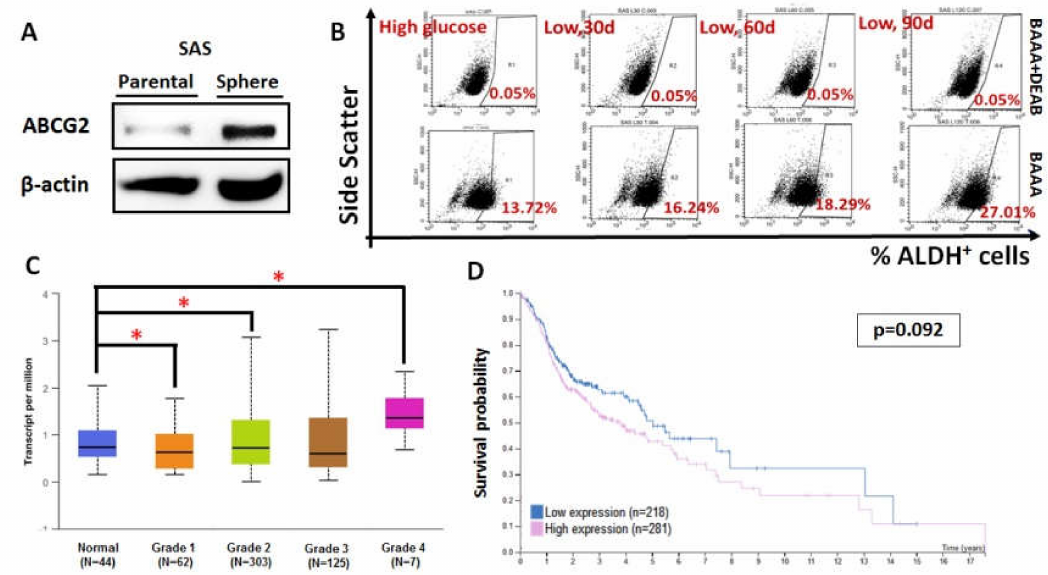
Figure 5. ABCG2 expression is associated with increased stemness, tumor grade, and HNC prognosis. ( A ) ABCG2 was enriched in SAS sphere culture compared with SAS parental cells. ( B ) Aldehyde dehydrogenase (ALDH) + cell population gradually increased once SAS cells were cultured in a medium containing lower glucose. ABCG2 expression increased with increasing low-glucose culture time. ALDH + percentage also increased with ABCG2 expression, with individual values of 16.24%, 18.29%, and 27.01%. BODIPY-aminoacetaldehyde (BAAA) is an ALDH substrate, and diethylaminobenzaldehyde (DEAB) is an inhibitor of ALDH activity. ( C ) Statistical analysis for ABCG2 mRNA levels in normal and primary HNC tissues stratified by clinical grades from UALCAN database. * p < 0.05. ( D ) Kaplan–Meier analysis for cancer-specific survival rates in HNSCC patients classified by ABCG2 expression using the Human Protein Atlas database. The expression cut-o ff value is 0.32